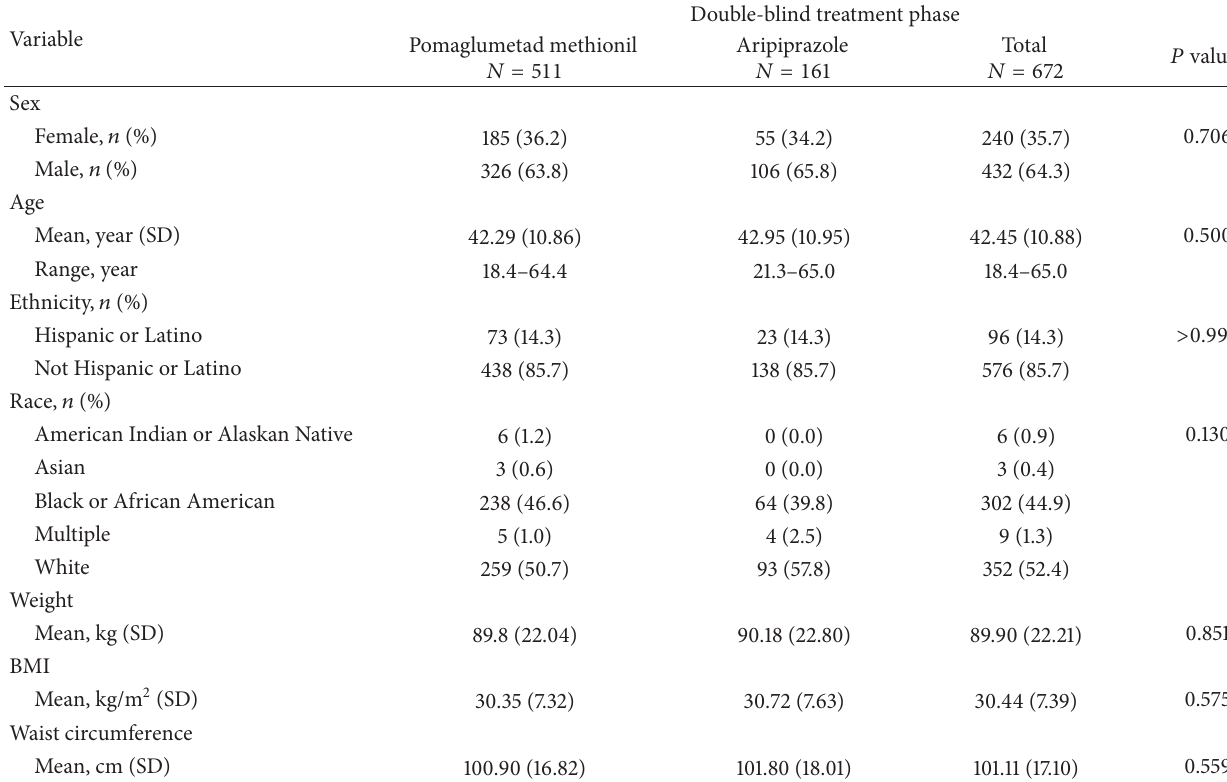
Table 1: Patient demographics and baseline